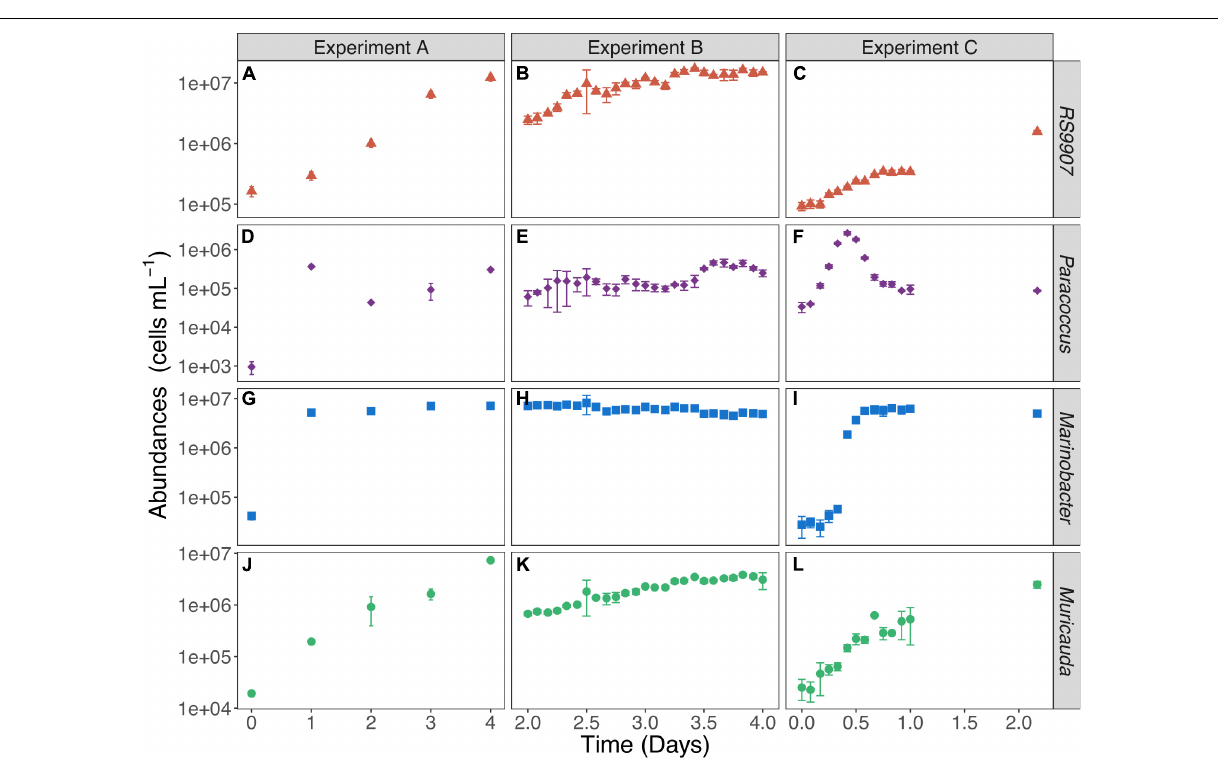
FIGURE 4 | Variations in the mean abundance of Synechococcus RS9907 (A–C) and the 3 heterotrophic bacteria [ Paracoccus (D–F) , Marinobacter (G–I) , Muricauda (J–L) ] at 30 ◦ C in the three experiments. Error bars represent the standard deviations of 4 replicates in experiment A and triplicates in experiments B and